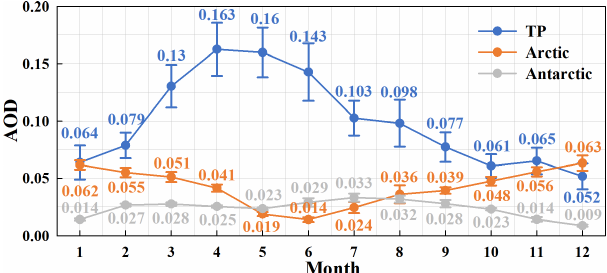
Figure 3. The monthly averages (dots) and SDs (bars) of AODs for the study period from June 2006 to December 2019 over the Arctic, Antarctic and